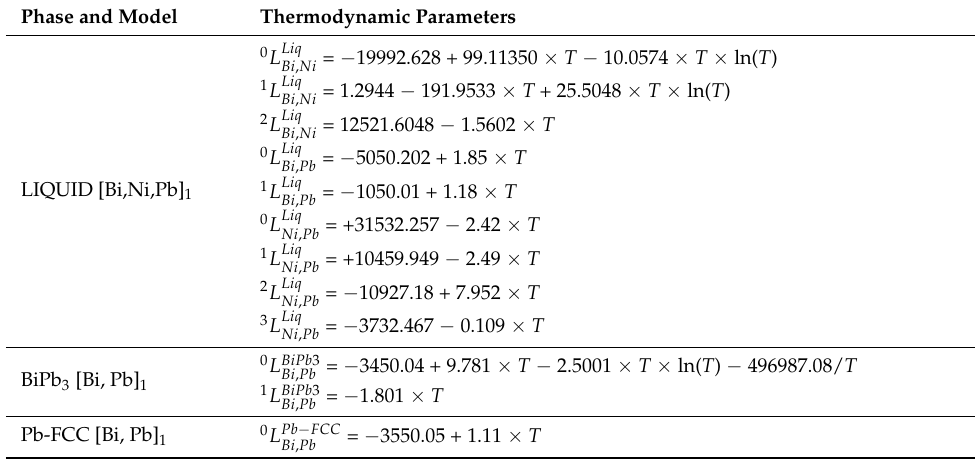
Table 2. Assessed parameters for the Bi-Ni-Pb ternary system. Phase and